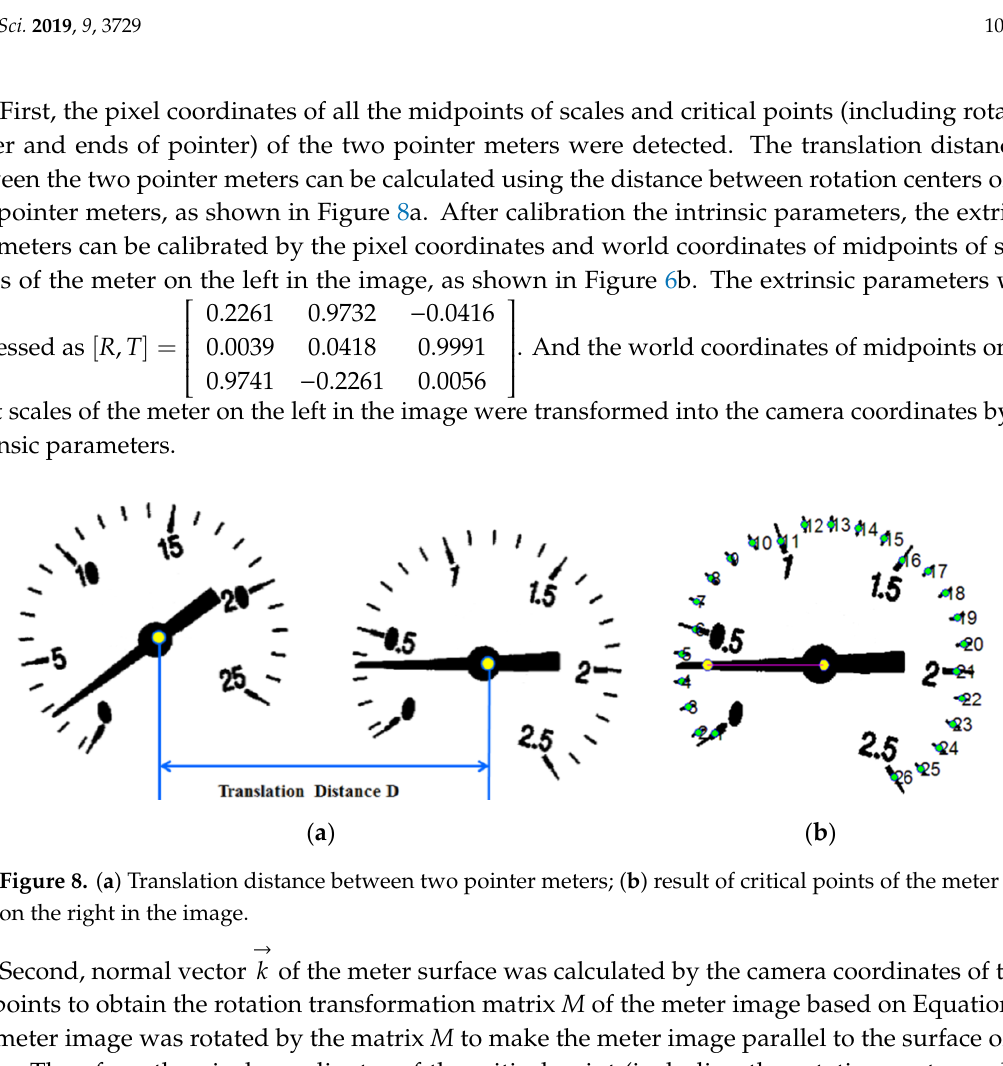
Table 8. Measurement readings of two pointer meters by two methods.